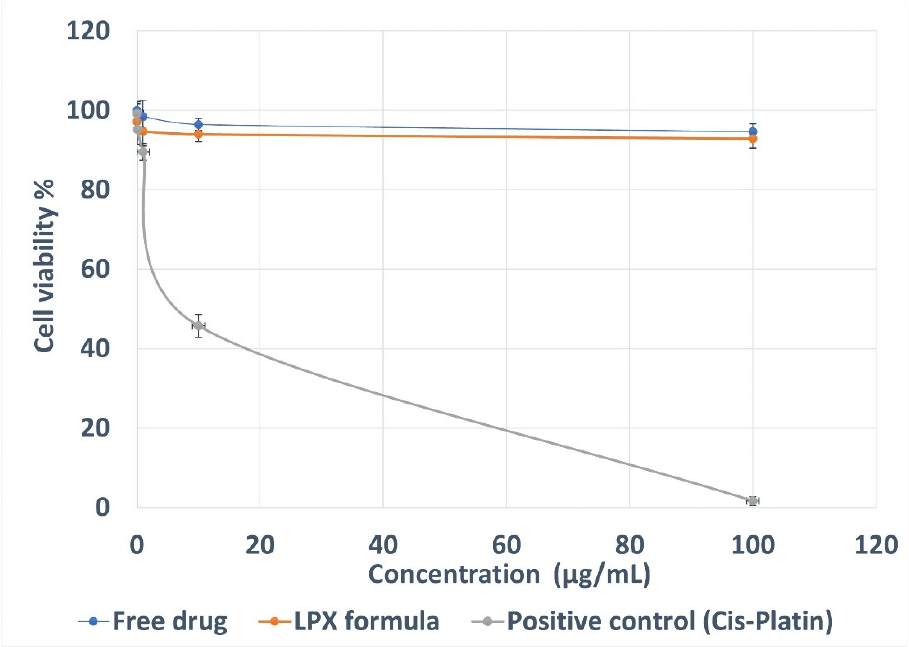
Sci. Pharm. 2023 , 91 , 1 Figure 8. Cell viability percent using SRB colorimetric assay . Abbreviation: SRB, sulforhodamine B. Figure 8. Cell viability percent using SRB colorimetric assay. Abbreviation: SRB, sulforhodamine B.